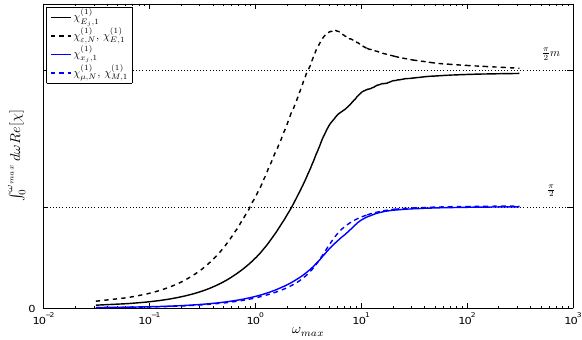
Fig. 8. Sum rules of the real part of the linear susceptibilities in- Figure 8: Sum rules of the real part of the linear susceptibilities indicated in the legend. The dicated in the legend. The theoretical values are indicated in the theoretical values are indicated in the figure.